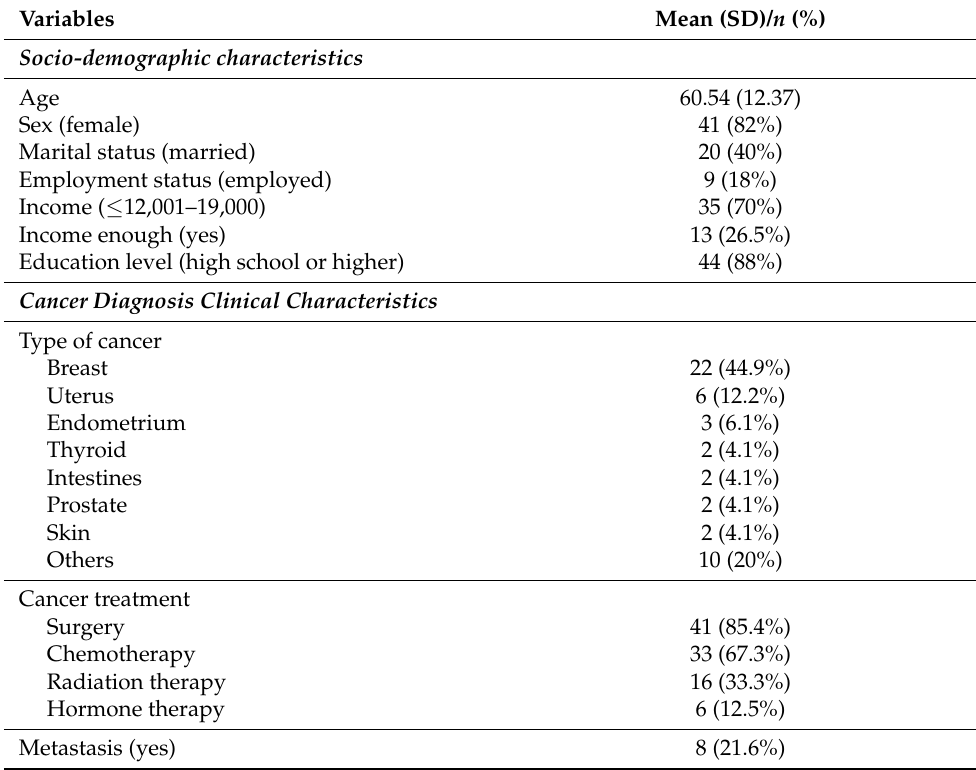
Table 1. Sociodemographic characteristics of the sample ( n = 51).